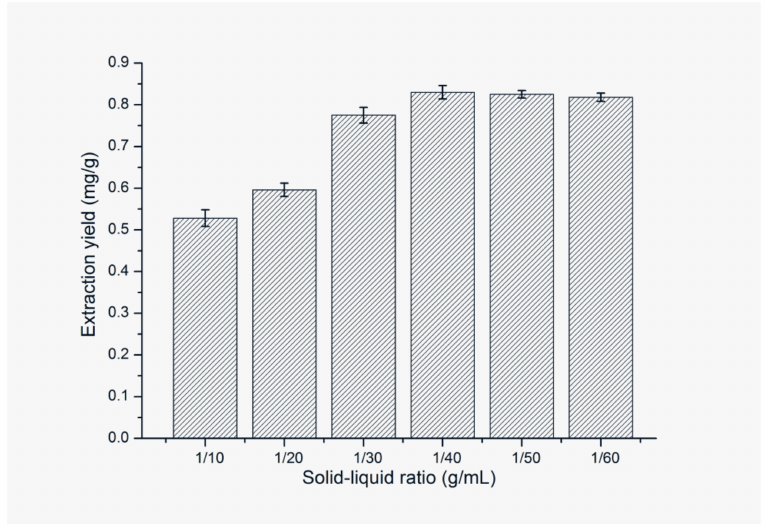
Figure 7. E ff ect of solid–liquid ratio on extraction yield of FA. Sample amount, 50 mg; type of IL, [C 4 mim]NTf 2 ; extraction temperature, 60 ◦ C; volume of IL, 0.8 mL; ultrasonic time, 9 min; centrifugal speed, 11,000 rpm; centrifugal time, 5